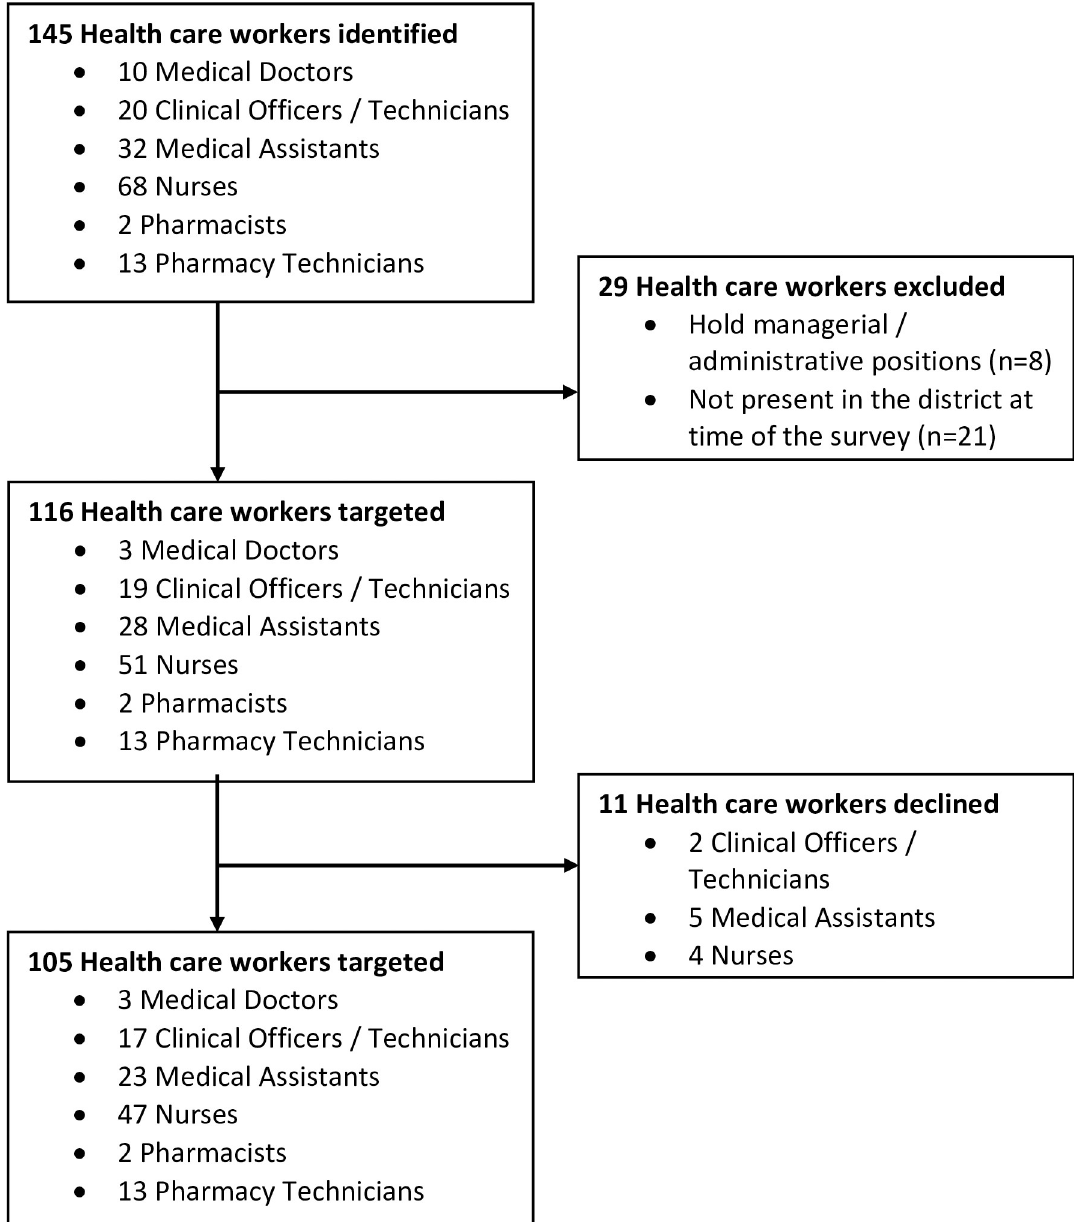
Fig 1. Health care workers targeted for snakebite survey in Neno District in 2021–2022. Mozambique spitting cobra [ Naja mossambica ]. Non-venomous snakes included Common house snake [ Boaedon capensis ] and Spotted bush snake [ Philothamnus semivariegatus ] [34,43]. These are common snakes in Malawi and known to be involved in snakebite. We uti- lized open-ended questions to solicit prescription and administration of SAV protocols and practice and why snakebites are considered a problem in the Neno District. Additionally, we asked if HCWs think that snakebite victims visit local healers before they reach the hospital and why this may be the case.